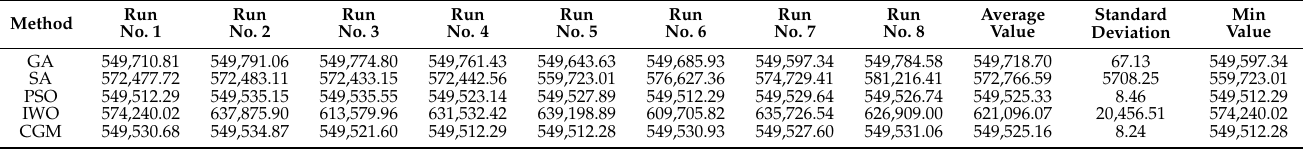
Table 4. Results of several runs of all optimization algorithms on a single configuration for the optimal-placement-of-resources problem in a ten-dimensional